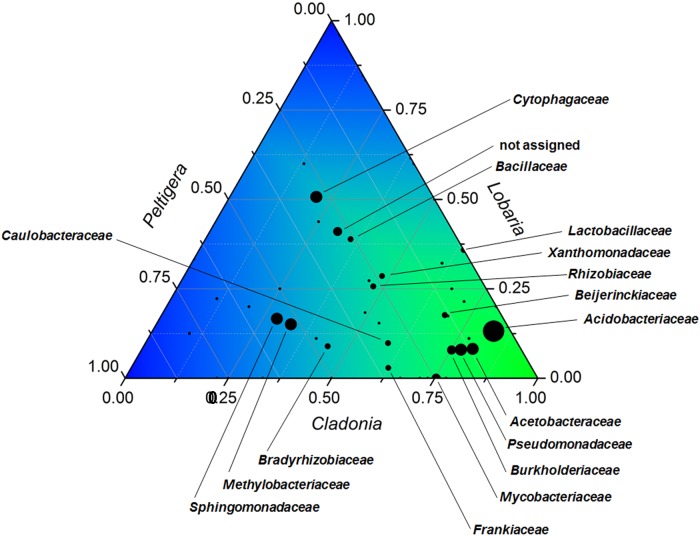
Ternary plot visualizing identified carriers of arsenic-related genes and their occurrence in the three analyzed lichens. The taxonomic composition is shown at family level for bacteria that hold arsenic-related functions in C. furcata, Lobaria pulmonaria, and Peltigera polydactylon. The bubble sizes correspond to the total abundance of each taxon. Taxa with a total occurrence <50 were not annotated. Origin v8.5 (http://originlab.com) was utilized for the visualization of the ternary diagram.